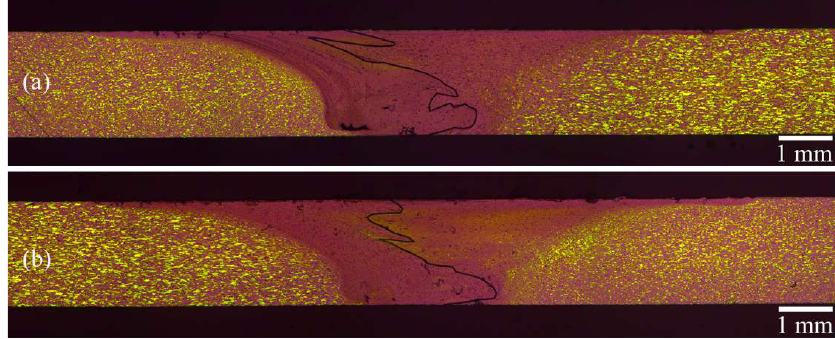
Figure 7. Cross sections of ( a ) FSW-WS = 8-AA7050-R and ( b ) FSW-WS = 8-AA2024-R.